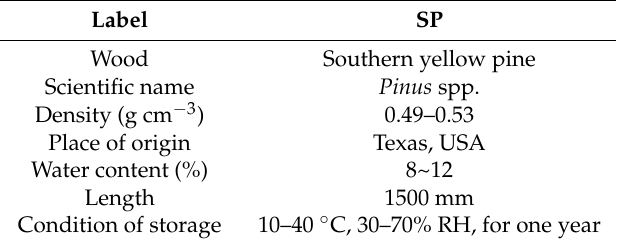
Table 1. Essential parameters of southern yellow pine.